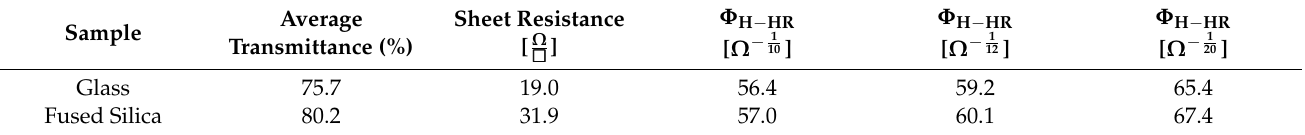
Table 1. Average transmittance, sheet resistance, and factor of merit (for n = 10, 12, and 20; see Equation (2)) of our best ZnO:Al TCO deposited on glass and fused